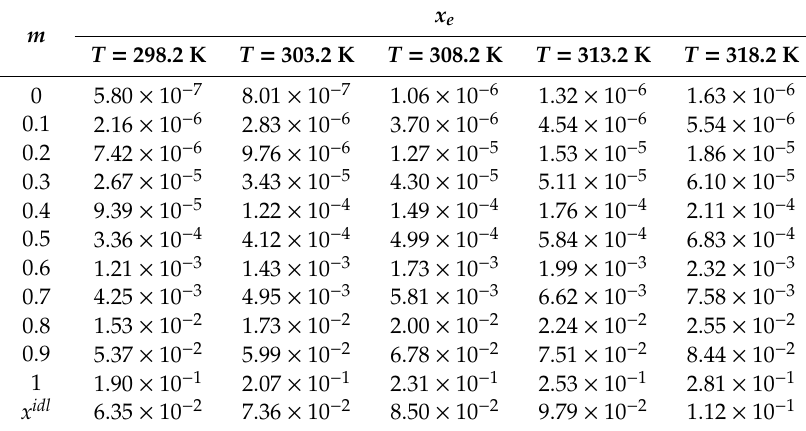
Table 2. Experimental mole fraction solubilities ( x e ) of flufenamic acid (FFA) in various Carbitol + water mixtures ( m ) at T = 298.2–318.2 K and p = 0.1 MPa a